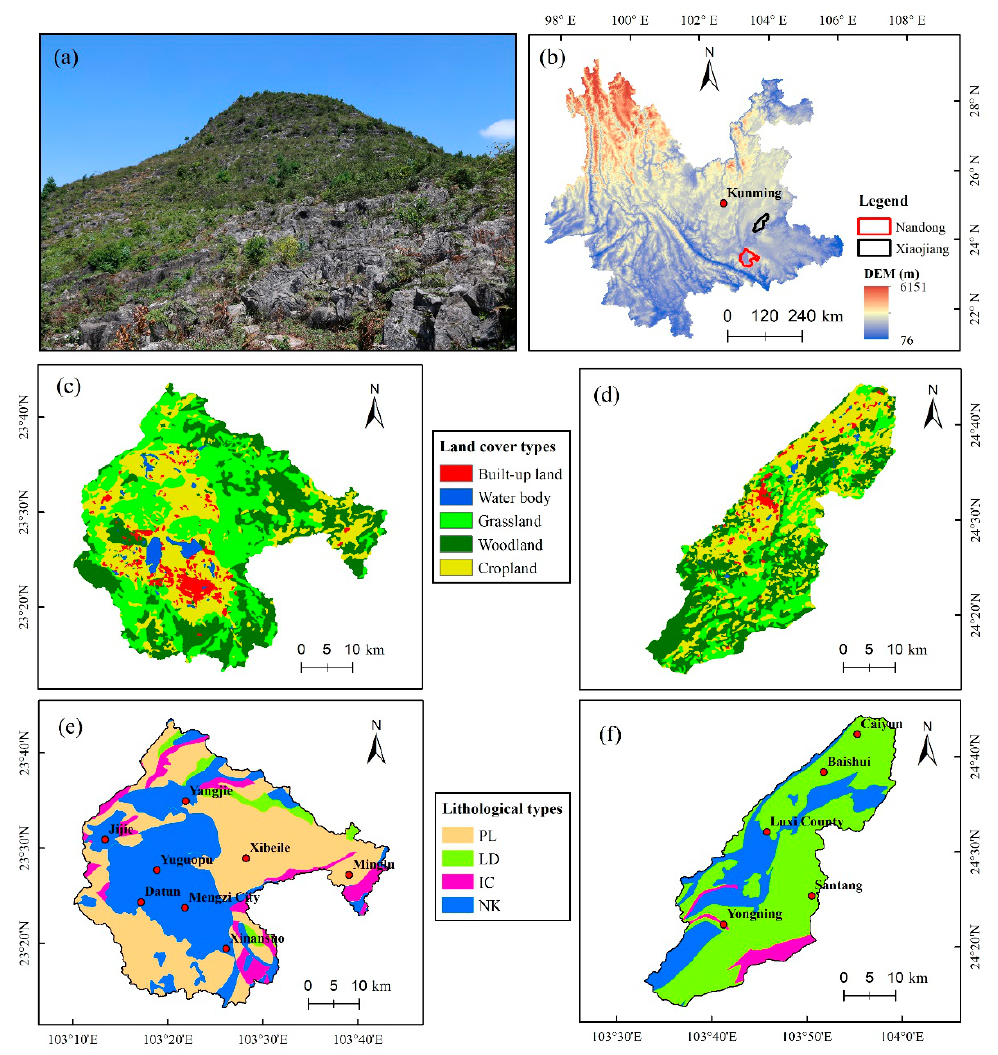
Figure 1. Study area: ( a ) An example of karst rocky desertification on hillsides near Xibeile Township, Mengzi city, Yunnan province (photo taken during a field survey in 2018); ( b ) the location of Yunnan province and Kunming (the provincial capital city), as well as of Nandong and Xiaojiang watersheds; ( c ) land cover types of the Nandong watershed in 2015; and ( d ) land cover types of the Xiaojiang watershed in 2015; and ( e ) lithological types and township / city seats in Nandong watershed; and ( f ) lithological types and township / county seats in Xiaojiang watershed. Main lithological attributes include PL (pure limestone), LD (limestone and dolomite interbedded layer), IC (impure carbonate rocks), and NK (non-karst